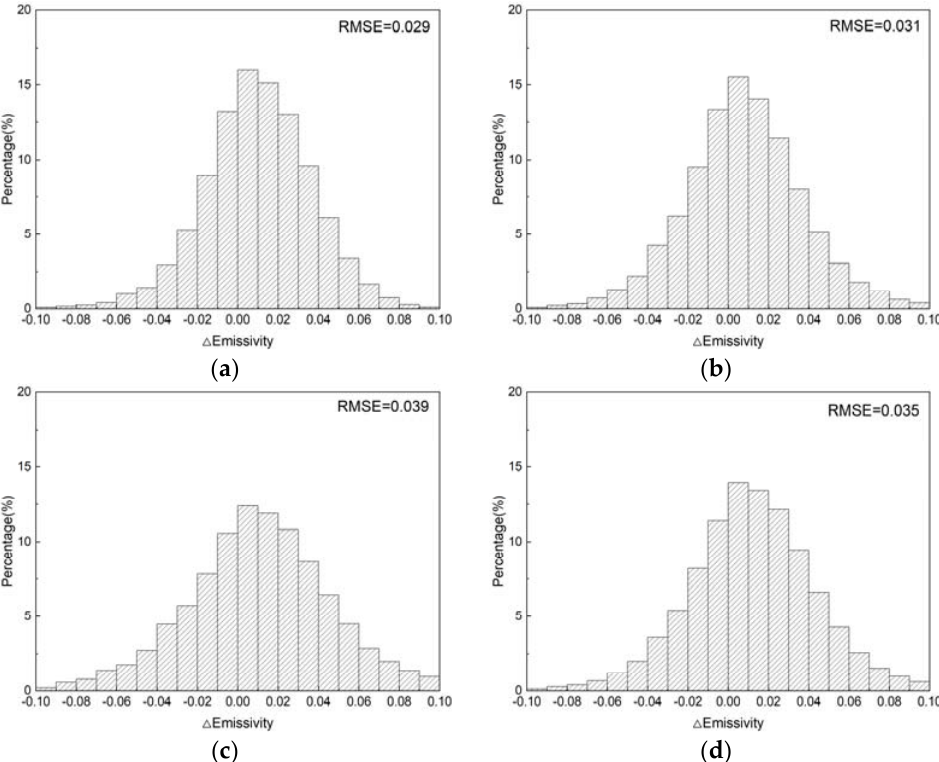
Figure 4. MIR emissivity residuals histograms of the proposed method. ( a ) Polar; ( b ) mid-latitude; ( c ) tropical; ( d ) overall.